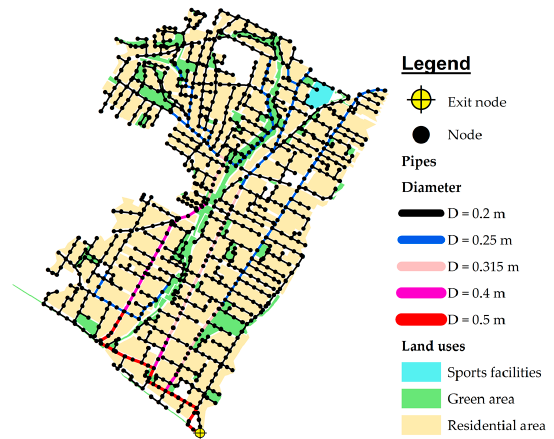
Figure 4. The case study sewer network in Kalyvia Thorikou in East Attica, Greece.